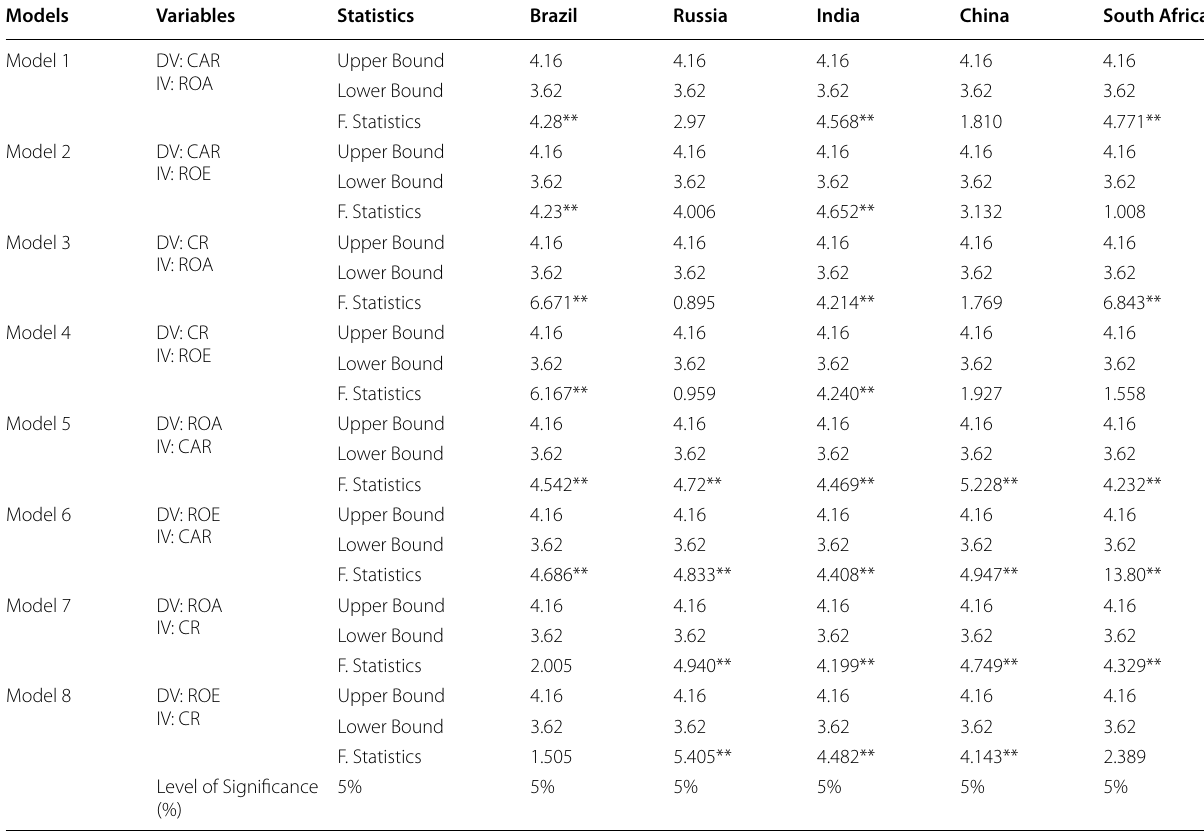
Table 2 ARDL Bound Test. Source : Authors’ estimations using